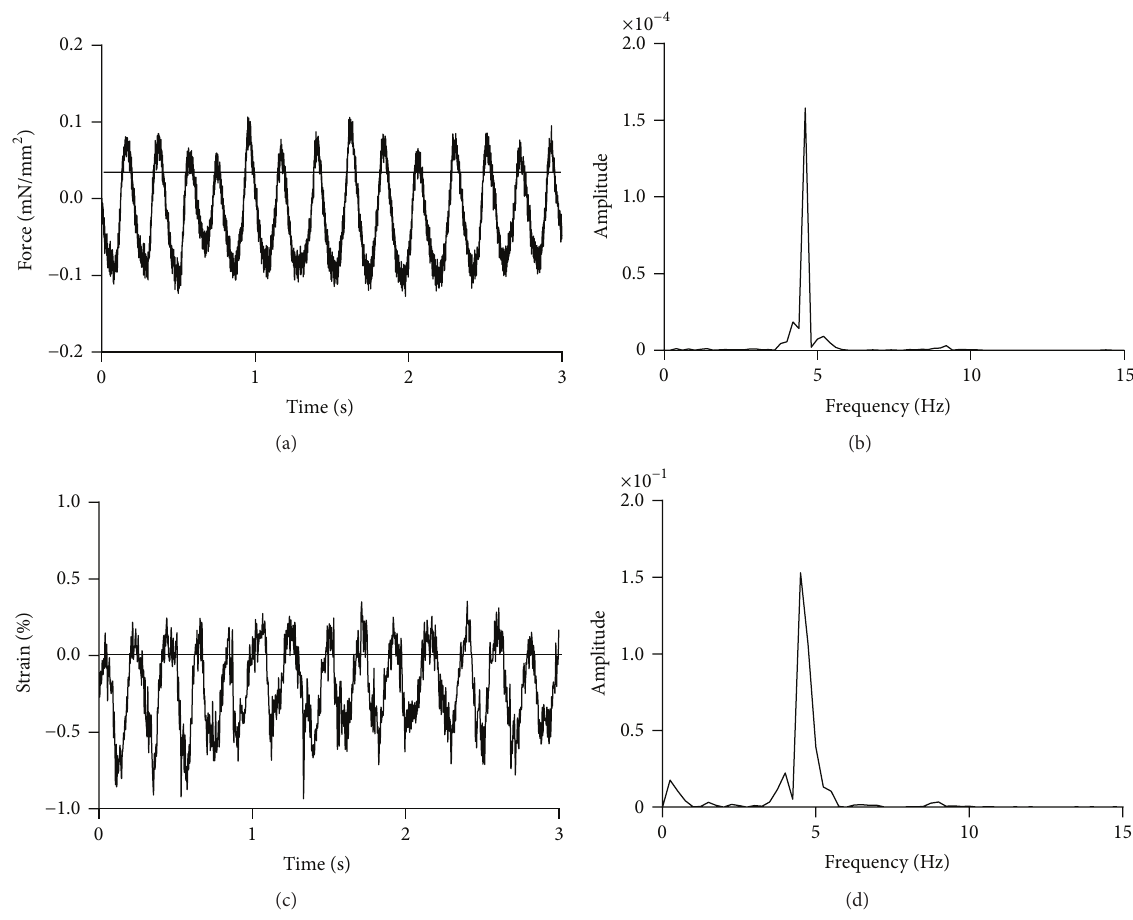
Figure 3: Data analysis. Example of an X-MET spontaneous contraction measured through the micro-force transducer (a), with the corresponding FFT analysis (b), and through the digital image correlation technique (c), again with the corresponding FFT analysis (d). The values in (b) and (d) are 𝑁 2 RMS and (𝑚/𝑚) 2 RMS respectively. Images were acquired at 500